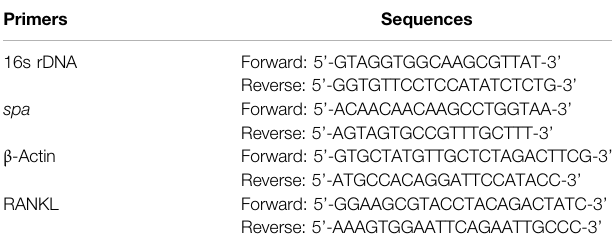
TABLE 1 | Speci fi c primers used for RT-qPCR.